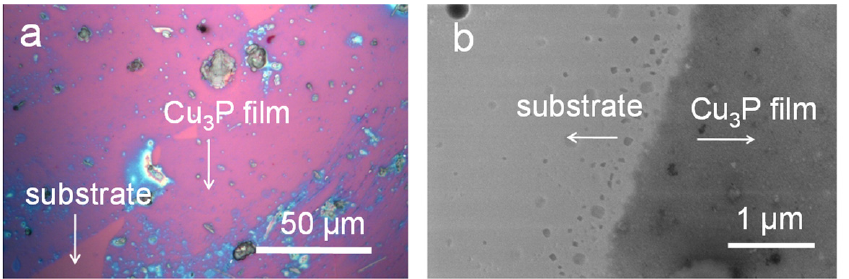
Figure 1. Typical optical microscope ( a ) and scanning electron microscope ( b ) images of the cuprous phosphide (Cu 3 P) nanofilm. The scale bars in ( a , b ) represent 50 and 1 μ m, respectively. The thickness and surface roughness were measured by AFM. Figure 2a,b show the typical AFM images of Cu 3 P nanofilm taken at two different locations on the same sample. The thickness of the film is ranging from ca. 4 to ca. 7 nm. The root-mean-square surface roughnesses of Figure 2a,b are 0.26 and 0.28 nm, respectively.